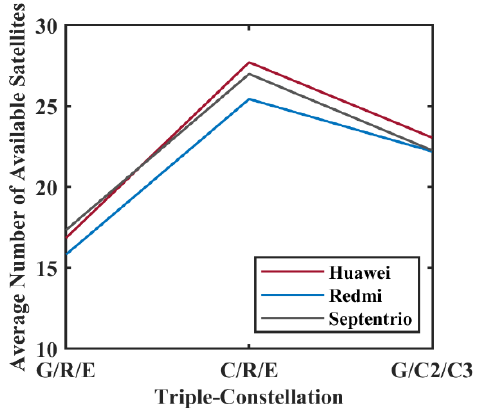
Figure 2. The average number of available satellites for velocity determination in dual-constellation.